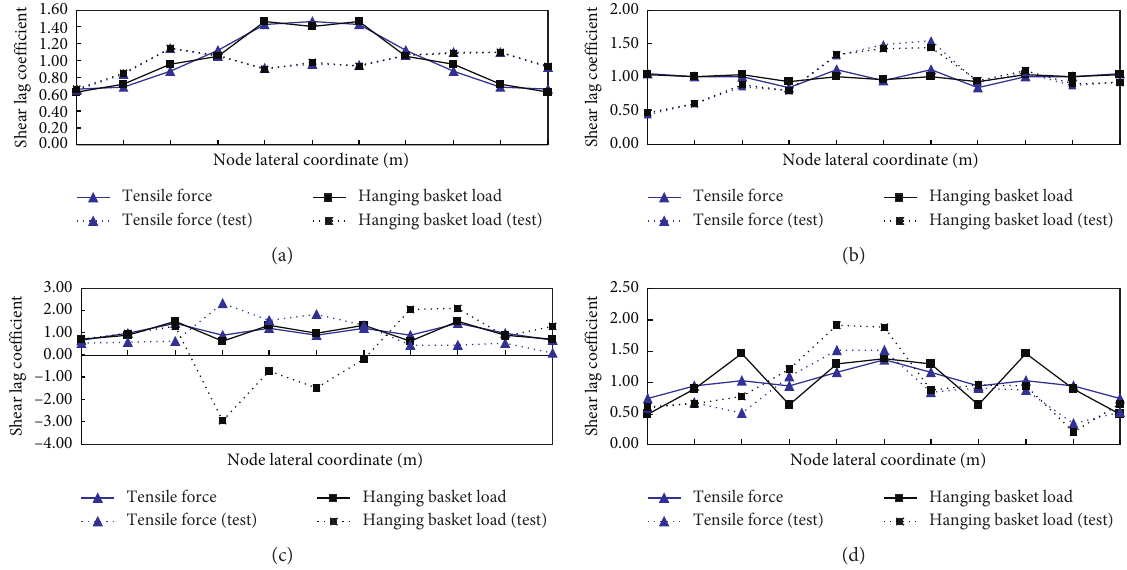
Figure 10: Contrast diagram of shear lag coefficient in G1-G4 (Condition 4): (a) G5 section, (b) G6 section, (c) G7 section, and (d) G8 section.